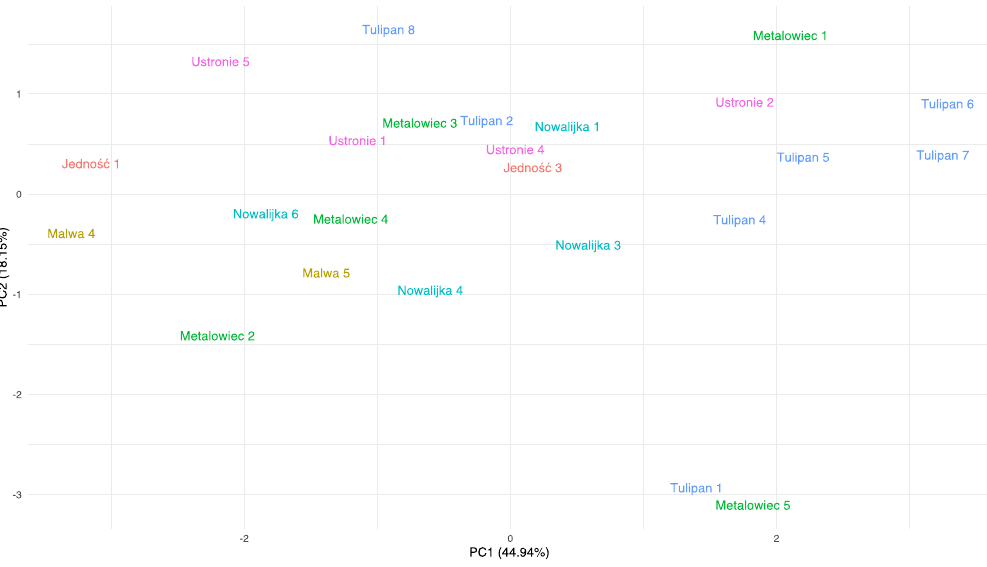
Figure 5. PCA relationship among studied allotment plots in respect to root parameters.